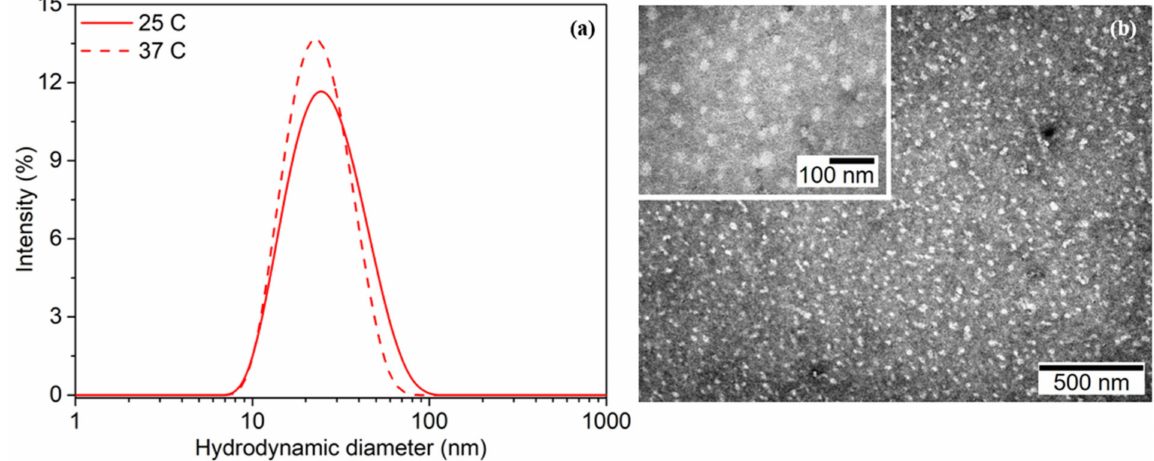
Figure 3. ( a ) DLS spectra of the BSA&phthaloNH 2 NPs at 25 ◦ C (solid line) and at 37 ◦ C (dashed line); ( b ) TEM images of the afresh synthesized BSA&phthaloNH 2